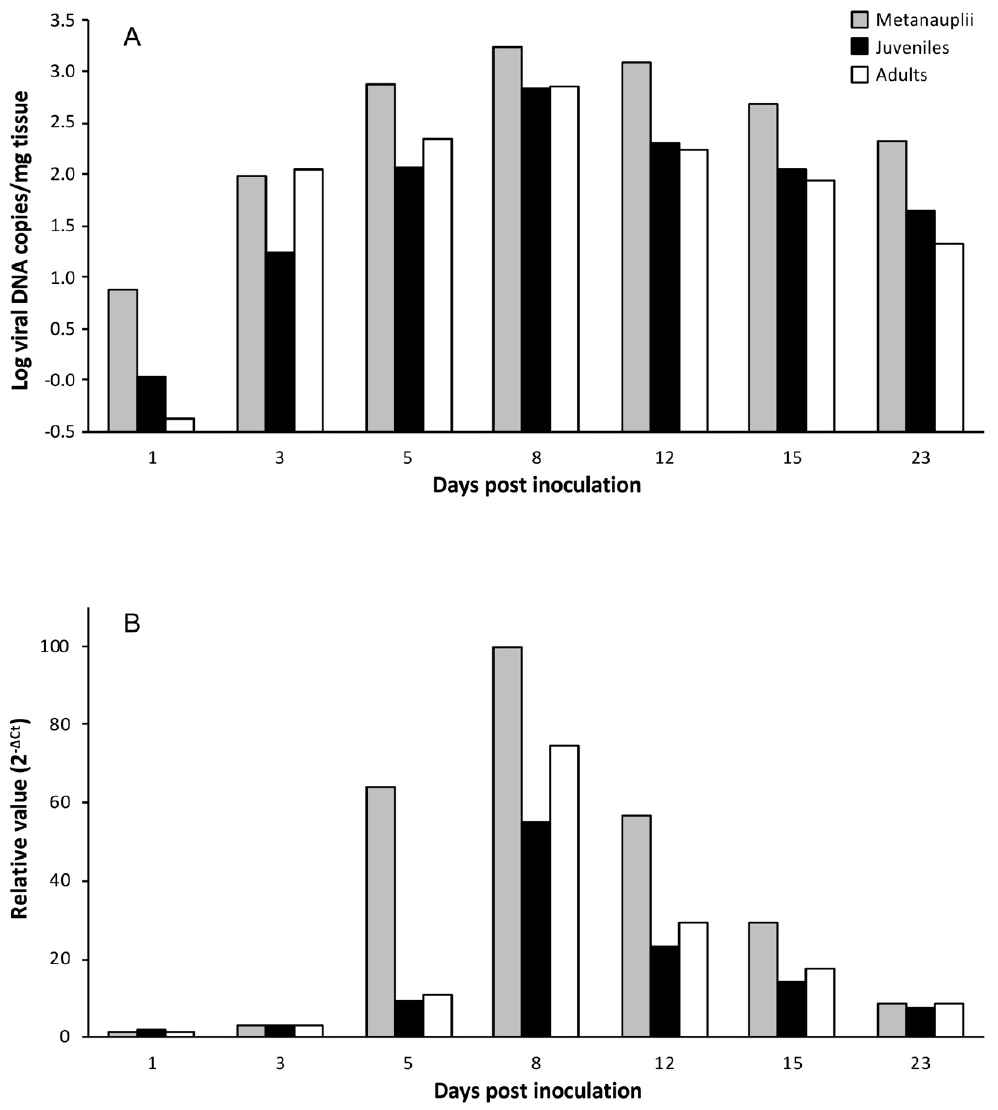
Figure 1. Temporal evolution of viral loads ( A ) and relative major capsid protein ( mcp ) gene expression values ( B ) in different developmental stages of Artemia inoculated with Lymphocystis disease virus (LCDV) SA25.